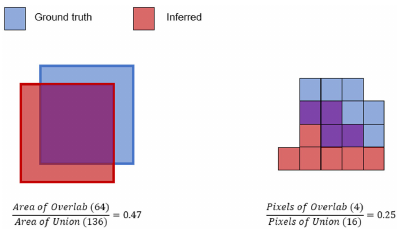
Figure 12. Example of calculating intersection of union; the traditional object detection methods calculate IoU through the bounding box area of the detection object ( left ), but the segmentation methods perform pixel-wise calculations ( right